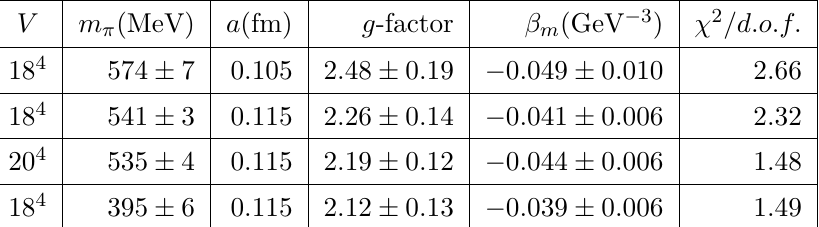
Table 3 . The magnetic dipole moment and the magnetic dipole polarizability of the charged (cid:26) meson with qs z = +1 for the lattice spacings 0 : 105 fm, 0 : 115 fm, the lattice volume 18 4 , various pion masses and for the lattice spacing 0 : 115 fm, the lattice volume 20 4 and the pion mass m (cid:25) = 535(4) MeV with their errors and (cid:31) 2 =d:o:f values. The results were obtained with the use of 3-